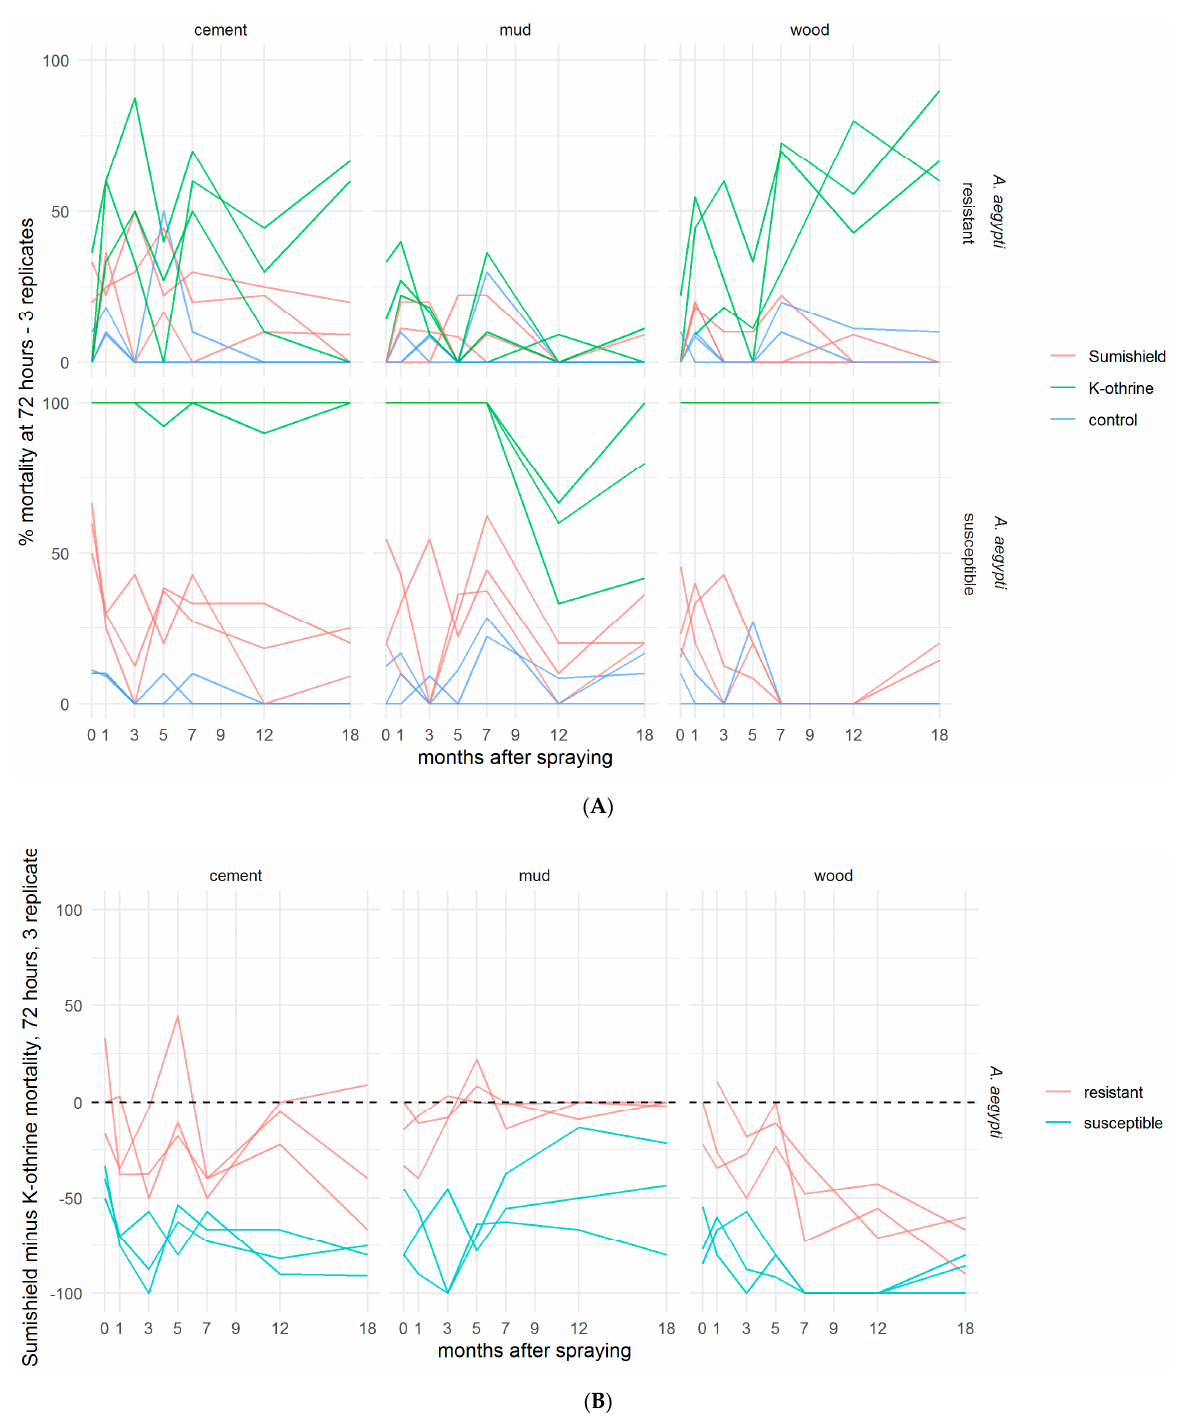
Figure 4. Residual efficacy of K-Othrine ® WG250 and SumiShield TM 50WG IRS treatments applied to different surface types against Aedes aegypti mosquitoes. ( A ) Mortality of resistant and susceptible strains 72 h after exposure to cement, mud, and wood surfaces treated with clothianidin or deltame- thrin IRS, in comparison to control water surfaces. ( B ) Mortality following deltamethrin exposure subtracted from mortality following clothianidin exposure. Values represent the additional kill ob- served over time with clothianidin when testing resistant mosquitoes compared to susceptible. In both assays ( A , B ), mosquitoes were exposed in a WHO cone bioassay 24 h, 1, 3, 5, 7, 9, 12, and 18 months after surfaces were treated. Data from 3 replicates of each treatment and surface type are presented as separate lines.